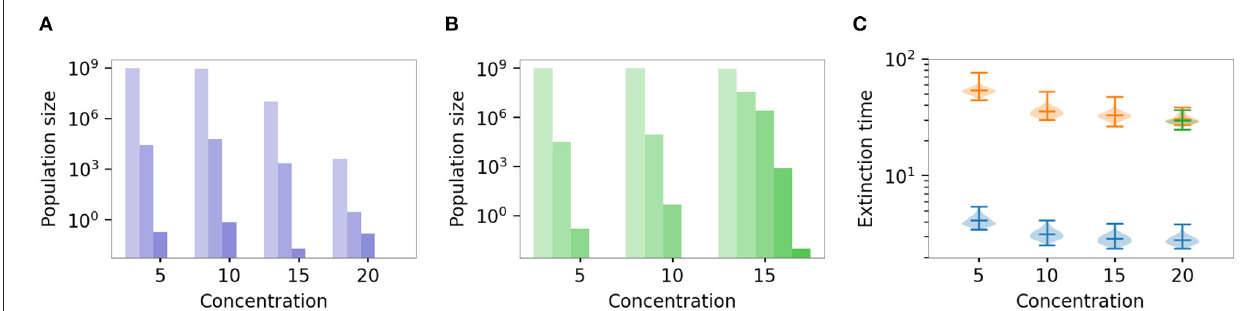
FIGURE 7 | Effect of drug concentration on genetic composition and survival time. Different colors represent different scenarios: plankton, genetic mechanisms only (blue); biofilm relying on physiological alterations only (red); biofilm relying on EPS protection only (green), biofilm protected by the combination of both mechanisms (purple). Panel (C) is a complement of panels (A,B) —if the populations survived, we show its genetic composition (A,B) , if not, we show distribution of extinction times (C) . (A,B) Genetic composition of the final populations that survived 7-day treatment. Mean sizes across 100 simulations. Different shades of the same color represent subpopulations with different numbers of mutations: lightest for wild type and darkest for the full (quadruple) mutant. (A) Both extracellular matrix protection and physiological alterations are considered in combination. (B) Only extracellular matrix protection is considered. Populations did not survive treatment with concentration A = 20 MIC, and the distribution of extinction times is shown in (C) . (C) Distribution of extinction times for treatment with various concentrations. Note the log scale of the y-axes. For the distributions of extinction times of all simulations on a linear scale, see Supplementary Figure 5 .